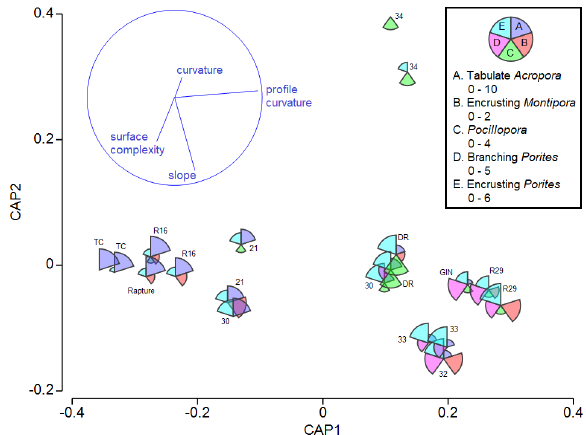
Figure 4. CAP constrained ordination using the Bray-Curtis dissimilarity values computed from live coral cover at the study sites. Vector overlays show gradients of 3D habitat metrics used in the analysis. Live coral cover (see legend) at each study site is superimposed on the ordination for